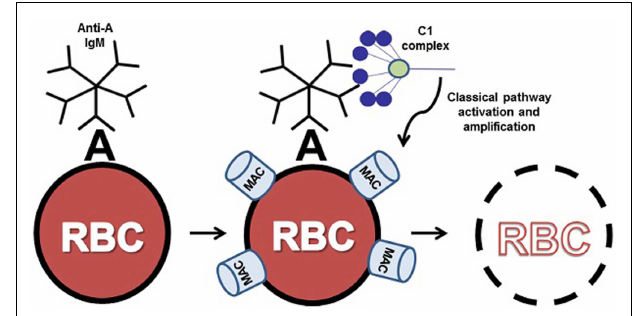
FIGURE 1 |ABO incompatible destruction of RBCs by the classical pathway of complement . In this example, transfused cells expressing A antigen have been exposed to incompatible recipient serum containing anti-A IgM.The bound IgM molecule is then recognized by serum complement C1 complex. Upon binding to IgM, C1 activates the classical pathway, resulting in complement deposition on the donor cell and eventual clearance or lysis of host RBCs by the membrane attack complex (MAC). For clarity, only C1 binding and MAC formation are illustrated